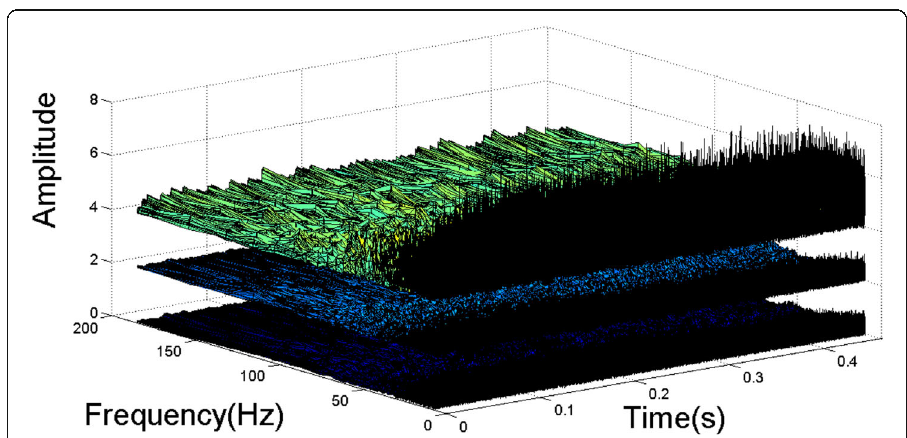
Fig. 14 Time-frequency diagram of 3 vibration signals in normal state